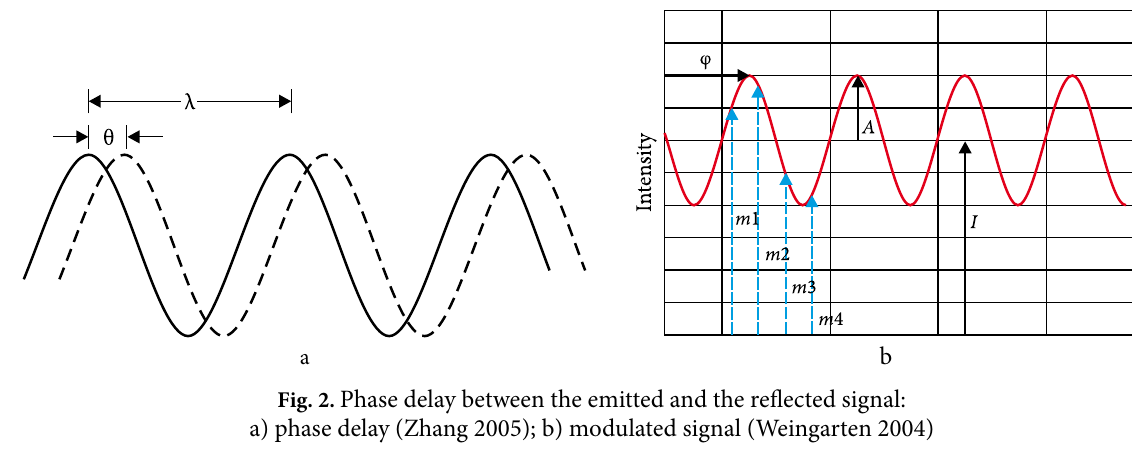
Fig. 2. Phase delay between the emitted and the reflected signal: